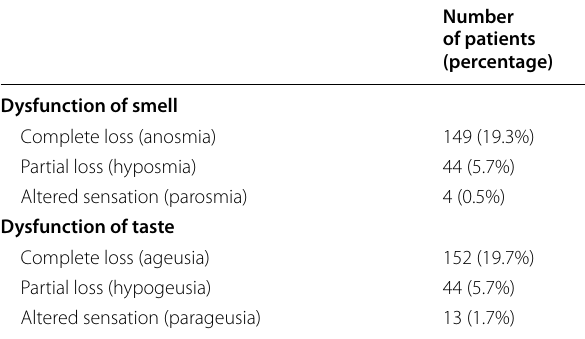
Table 1 Categorization of smell and taste abnormalities in our study population